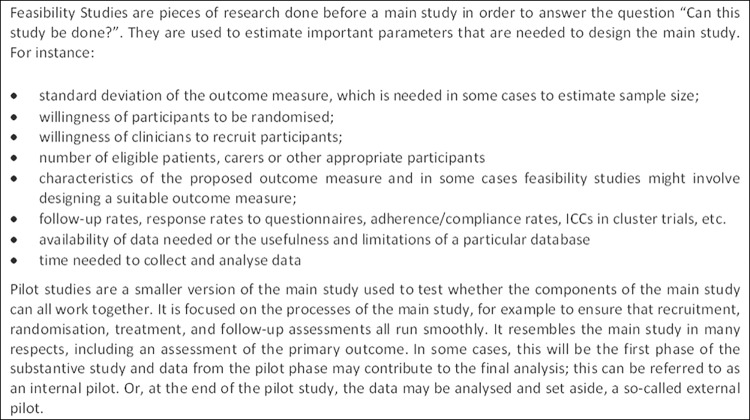
NIHR definitions [5, 6].